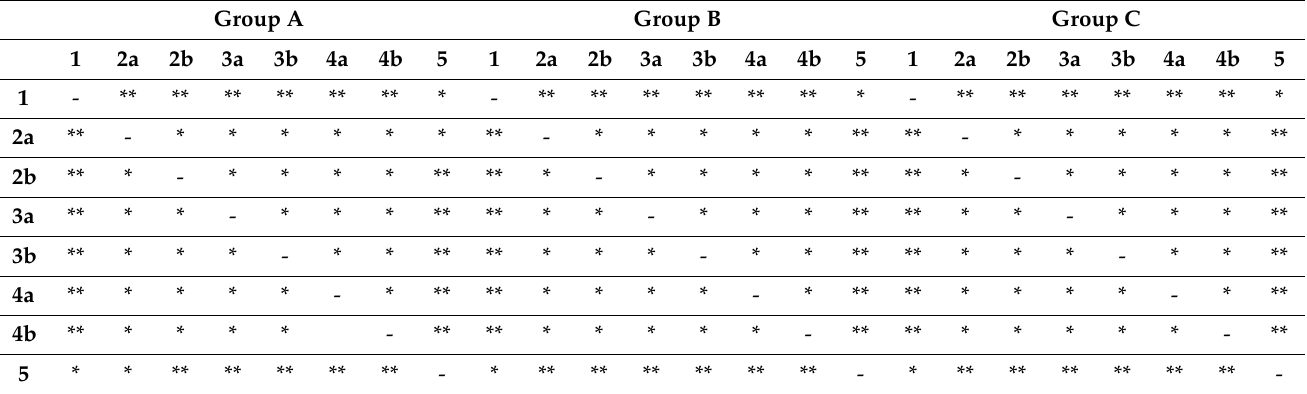
Table 3. Statistical differences between study subgroups in groups A, B, and C.